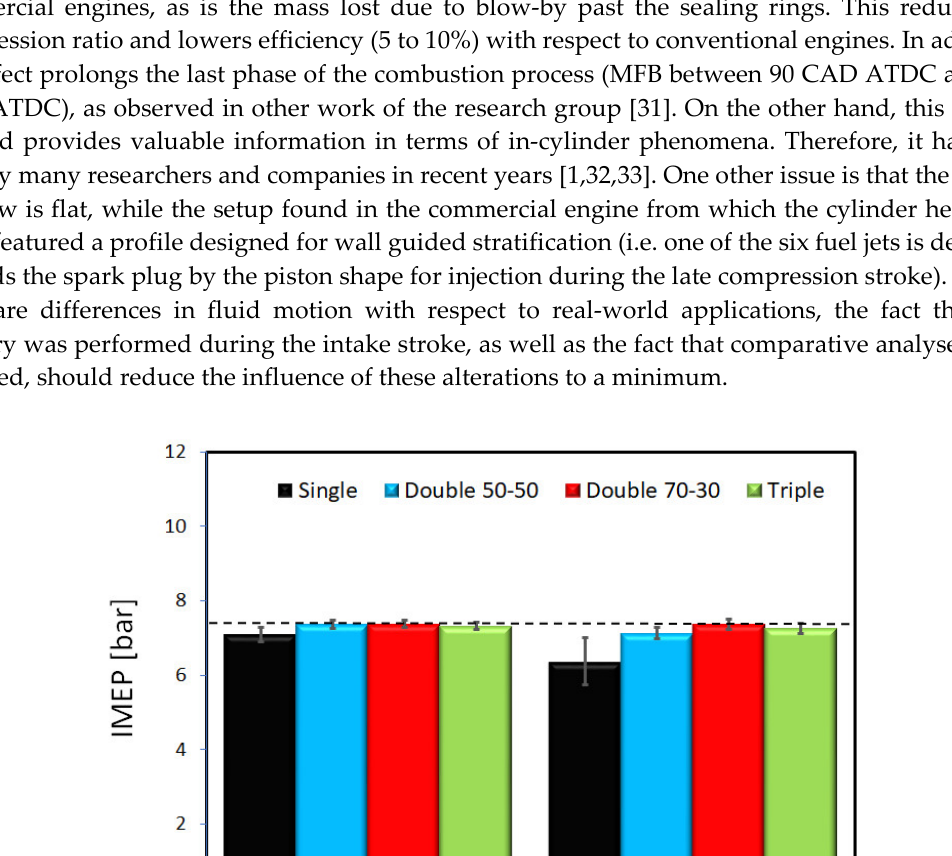
Figure 8. One of the two ‘extreme’ cases with respect to this pollutant category were